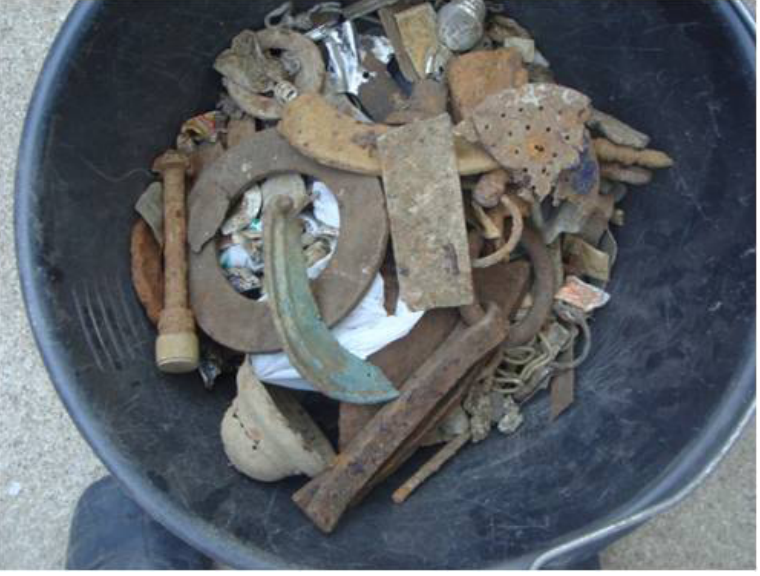
Figure 2: Identifying artefacts according to the detectorists: Bronze-Age sickle in a trash bucket. © all rights